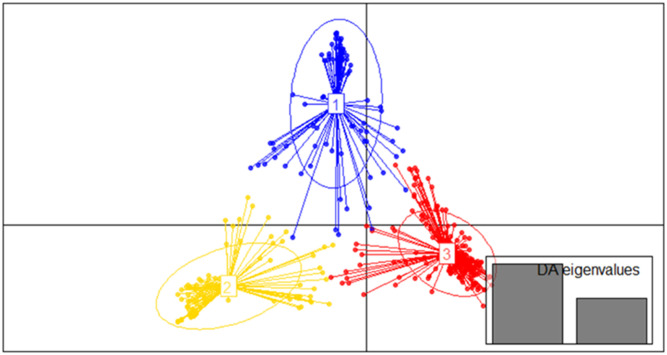
Scattered plot of DAPC, each color represents one cluster.